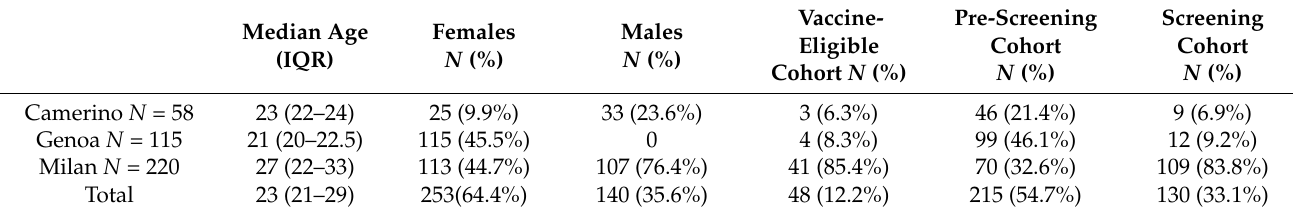
Table 1. Baseline characteristics of patients enrolled from sports medicine centers and universities located in three cities in different Italian Regions: Milan (Lombardy), Genoa (Liguria), and Camerino (Marche) in Northern/Central Italy.